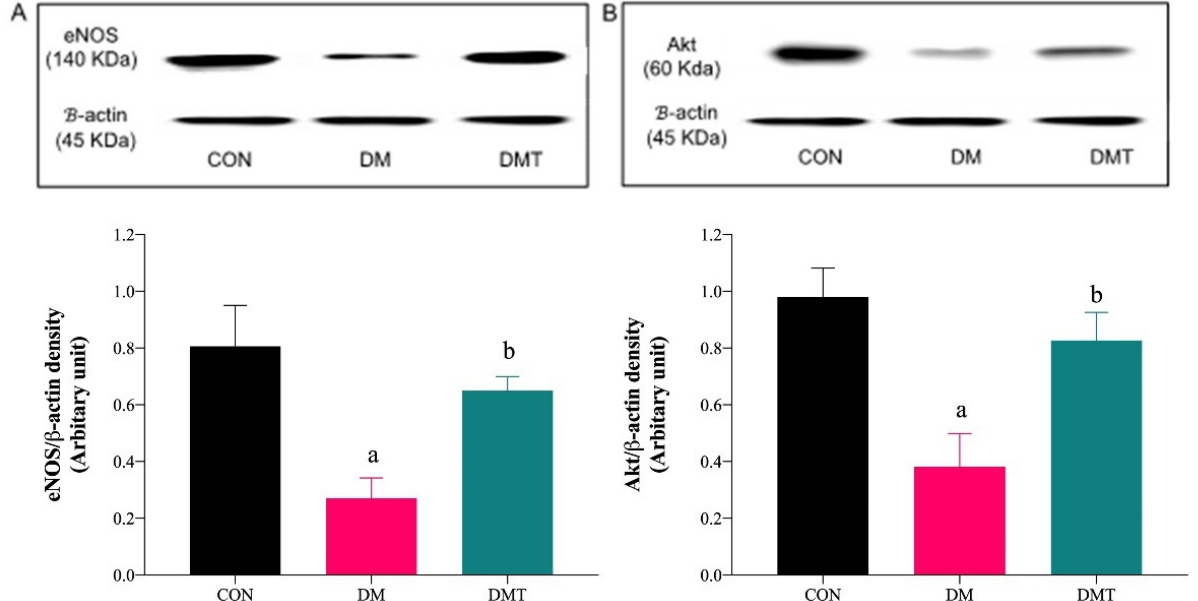
Figure 4. Representative blots showing the density of the protein bands for ( A ) eNOS and ( B ) Akt in rat aorta. Graphical representations of the data are normalised to β -actin (n = 9). a p < 0.05 vs. CON, b p < 0.05 vs. DM. Abbreviation: CON; Control, DM; Diabetes, DMT; Diabetes receiving TUDCA, eNOS; Endothelial nitric oxide synthase, and Akt; Protein Kinase B .